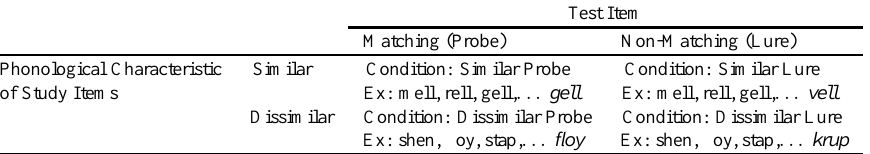
Table 1 Summary of trial types presented to each subject. Each trial condition is characterized by the type of study items presented, either phonologically similar or dissimilar, and by the type of test item presented, either probe (matching) or lure (non-matching). In the examples for each cell, study items appear in normal typeface, while test items are italicized Test Item Matching (Probe) Non-Matching (Lure) Phonological Characteristic Similar Condition: Similar Probe Condition: Similar Lure of Study Items Ex: mell, rell, gell, . .. gell Ex: mell, rell, gell, . .. vell Dissimilar Condition: Dissimilar Probe Condition: Dissimilar Lure Ex: shen, floy, stap, ... floy Ex: shen, floy, stap, ...